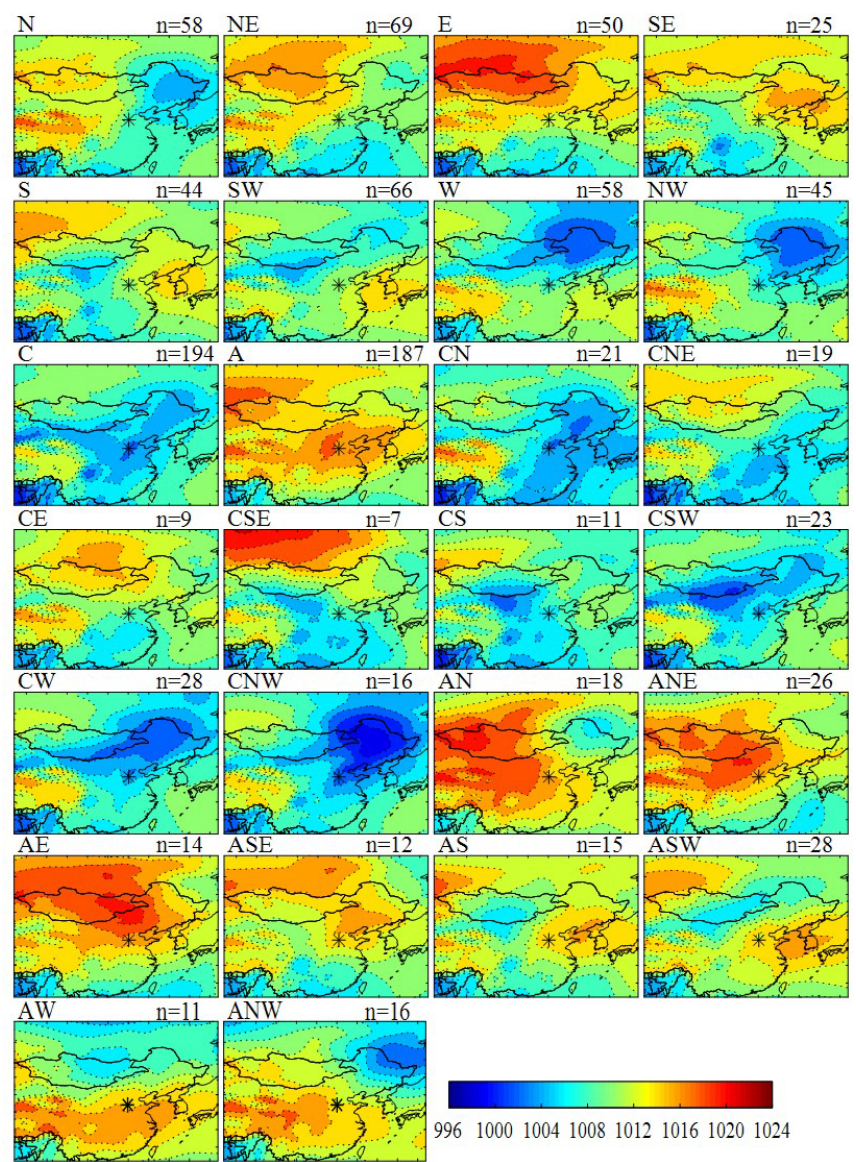
Figure 4. Mean surface pressure field (unit: hPa) for the 26 weather types during April–October of 2013–2017 and occurrence days (1070d in total). “*” indicates the center of northern